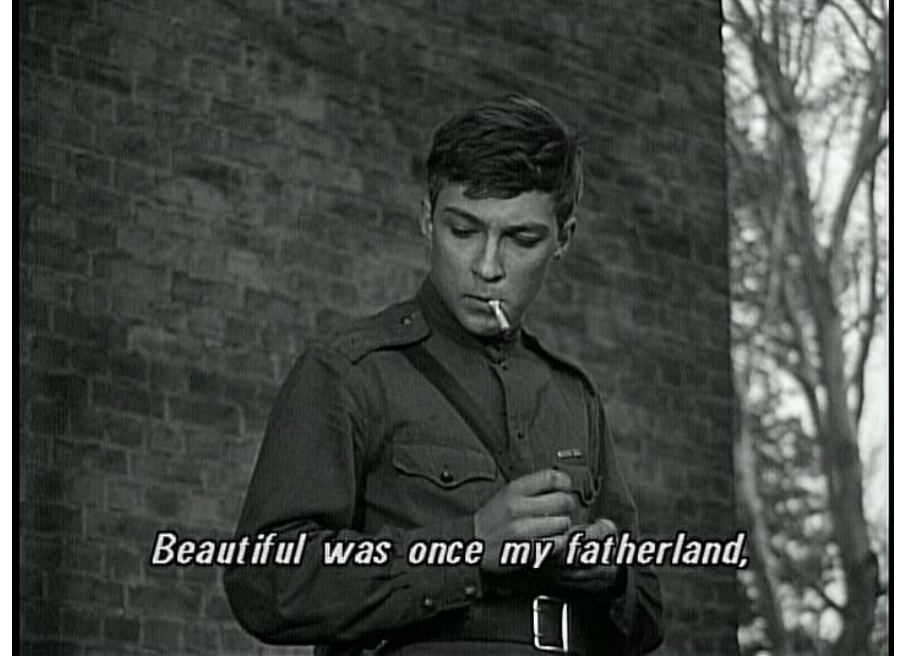
Figure 1. a. Gregor Hecker, the protagonist of Konrad Wolf‘s I was Nineteen . b. Opening sequence: the first encounter of the prodigal son with the homeland. c. The Heimat as a sphere of violence and